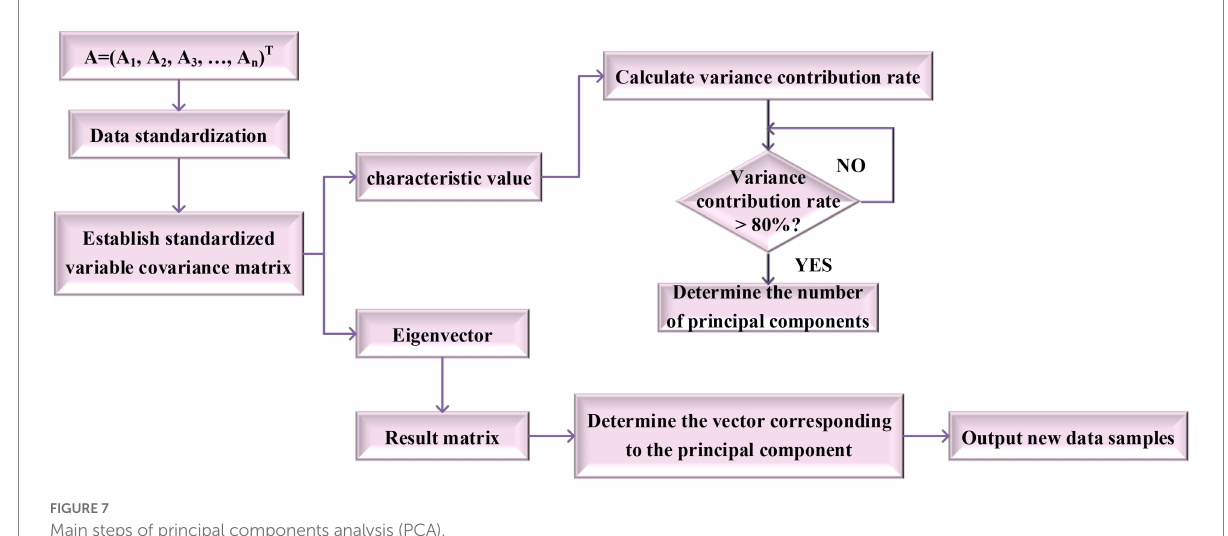
FIGURE 7 Main steps of principal components analysis